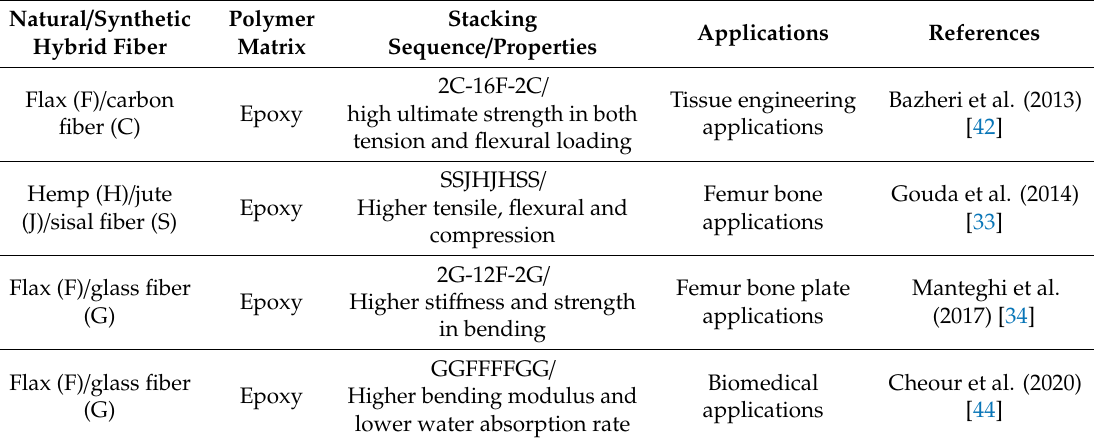
Table 1. Work reported on stacking sequence of hybrid polymer